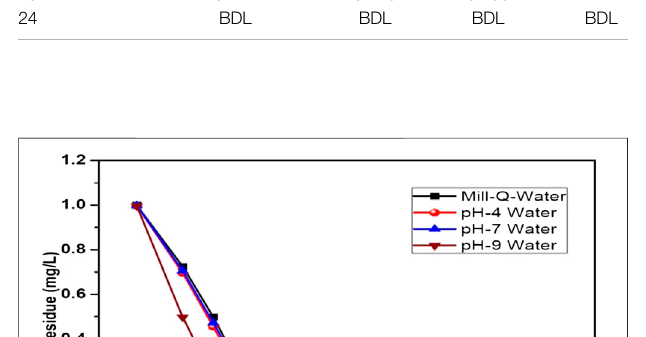
TABLE 3 | Dissipation data for photolytic decontamination of fl umioxazin in water under direct sunlight.